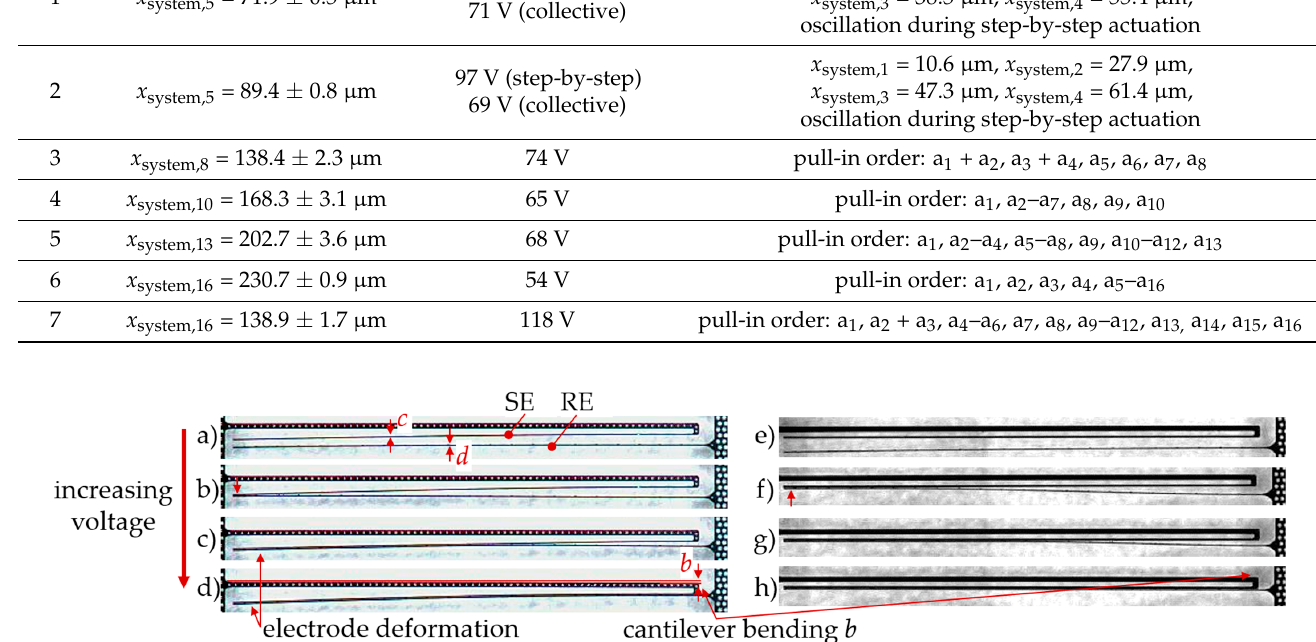
Figure 9. Pull-in depending on electrode thickness, ( a – d ) c = d = 5 µm, ( e – h ) c = 10 µm, d = 5 µm, detailed description in the continuous text.